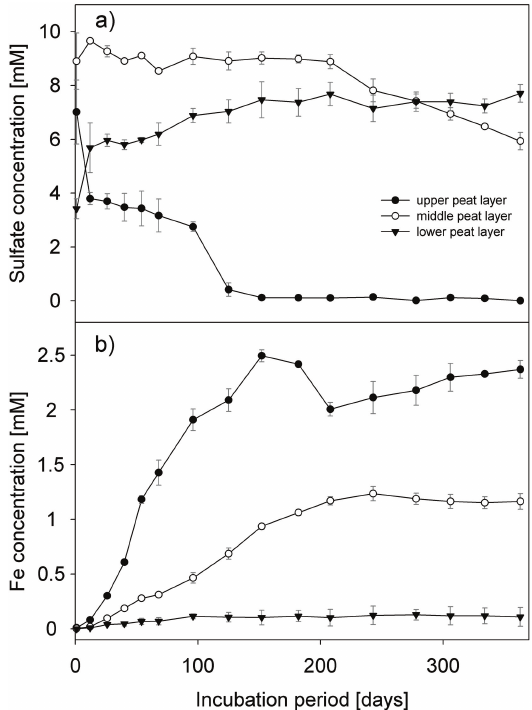
Fig. 3. Peat layer incubation: Sulfate (a) and iron (b) concentrations in the pore water of the upper, middle and lower peat layer over the 363-day incubation period (mean ± SD, n =